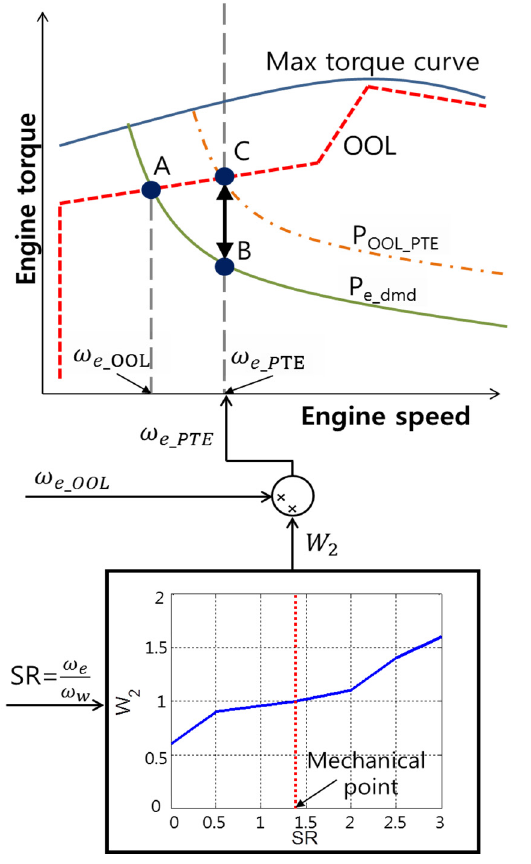
Figure 15. Engine operation for battery